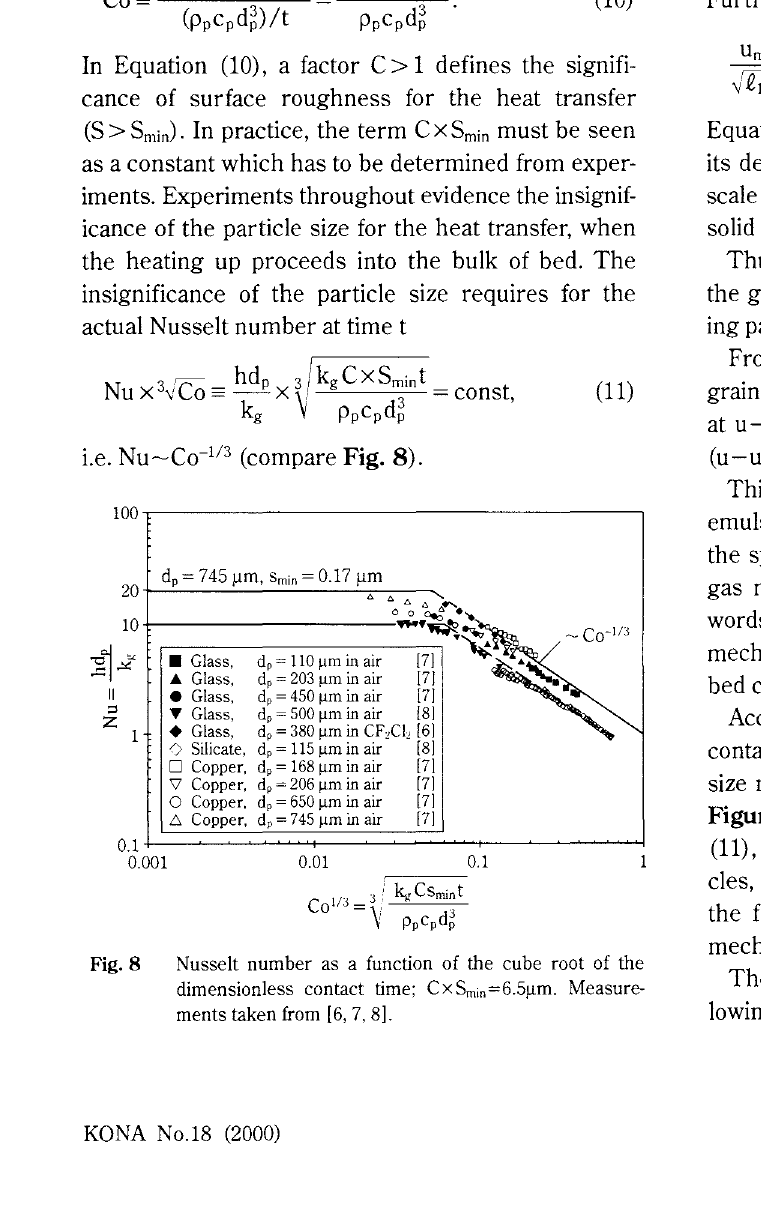
Fig. 8 Nusselt number as a function of the cube root of the dimensionless contact time; CxSmin=6.5).lm. Measure ments taken from [6, 7,